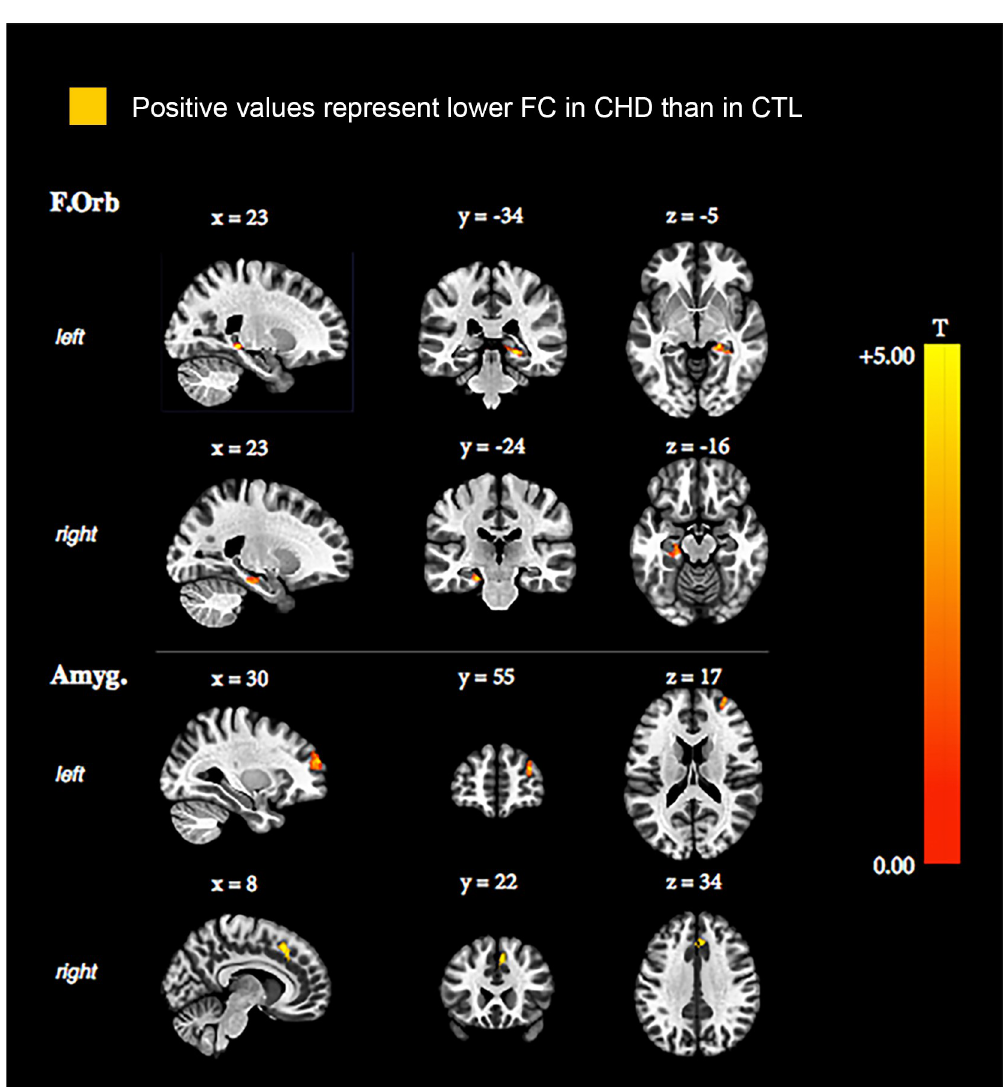
Fig 1. Functional connectivity differences between CHD and control groups where CHD presented lower functional connectivity. CHD: congenital heart disease, CTL: controls, F.Orb: fronto-orbital network, Amyg: amygdalar network.